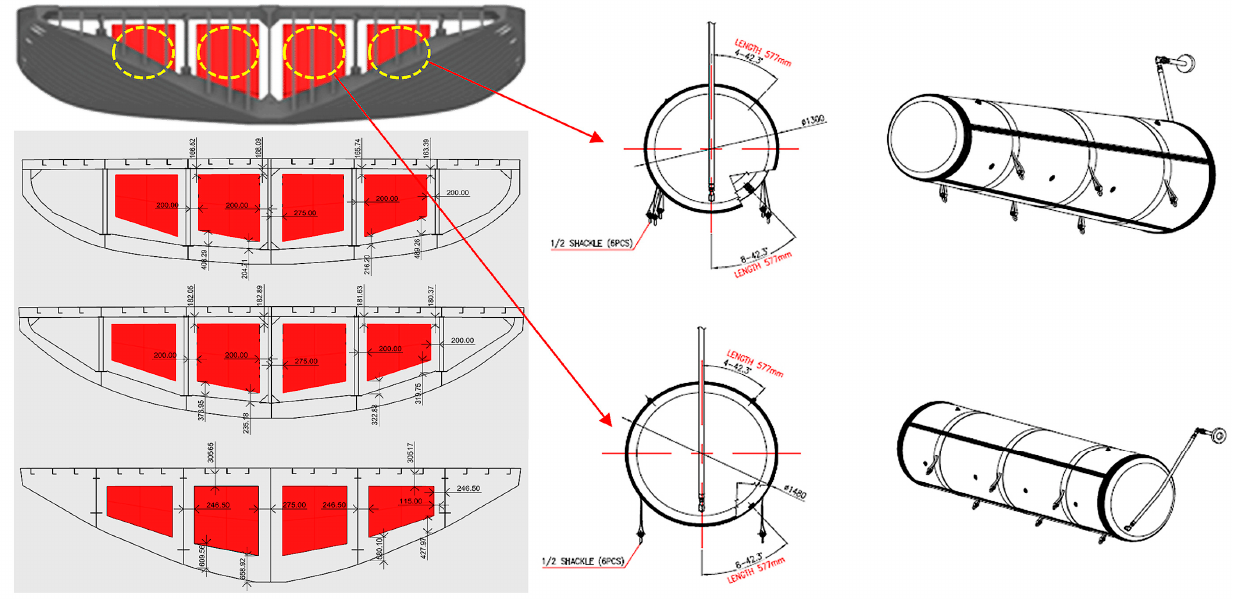
Figure 9. Example of the BSS installation space analysis and buoyancy chamber design.